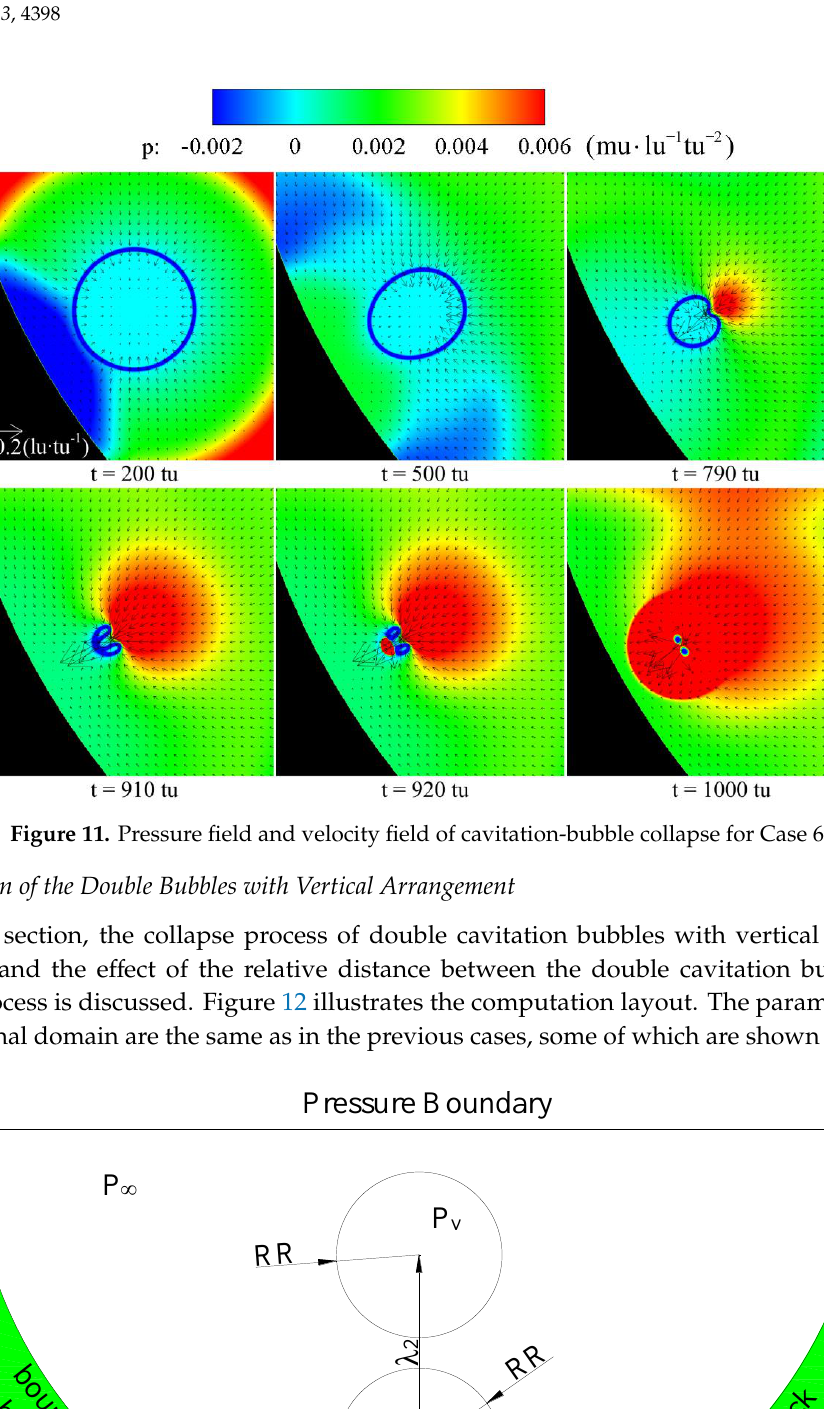
Figure 10. Pressure field and velocity field of cavitation-bubble collapse for Case 5.